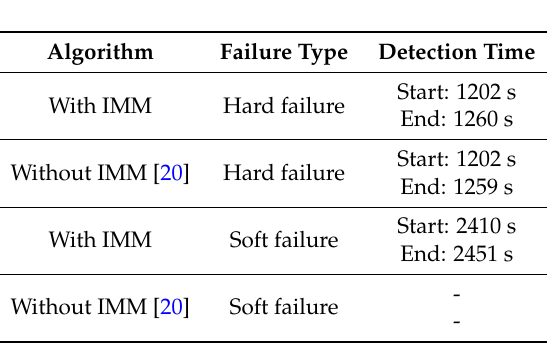
Table 5. Initial